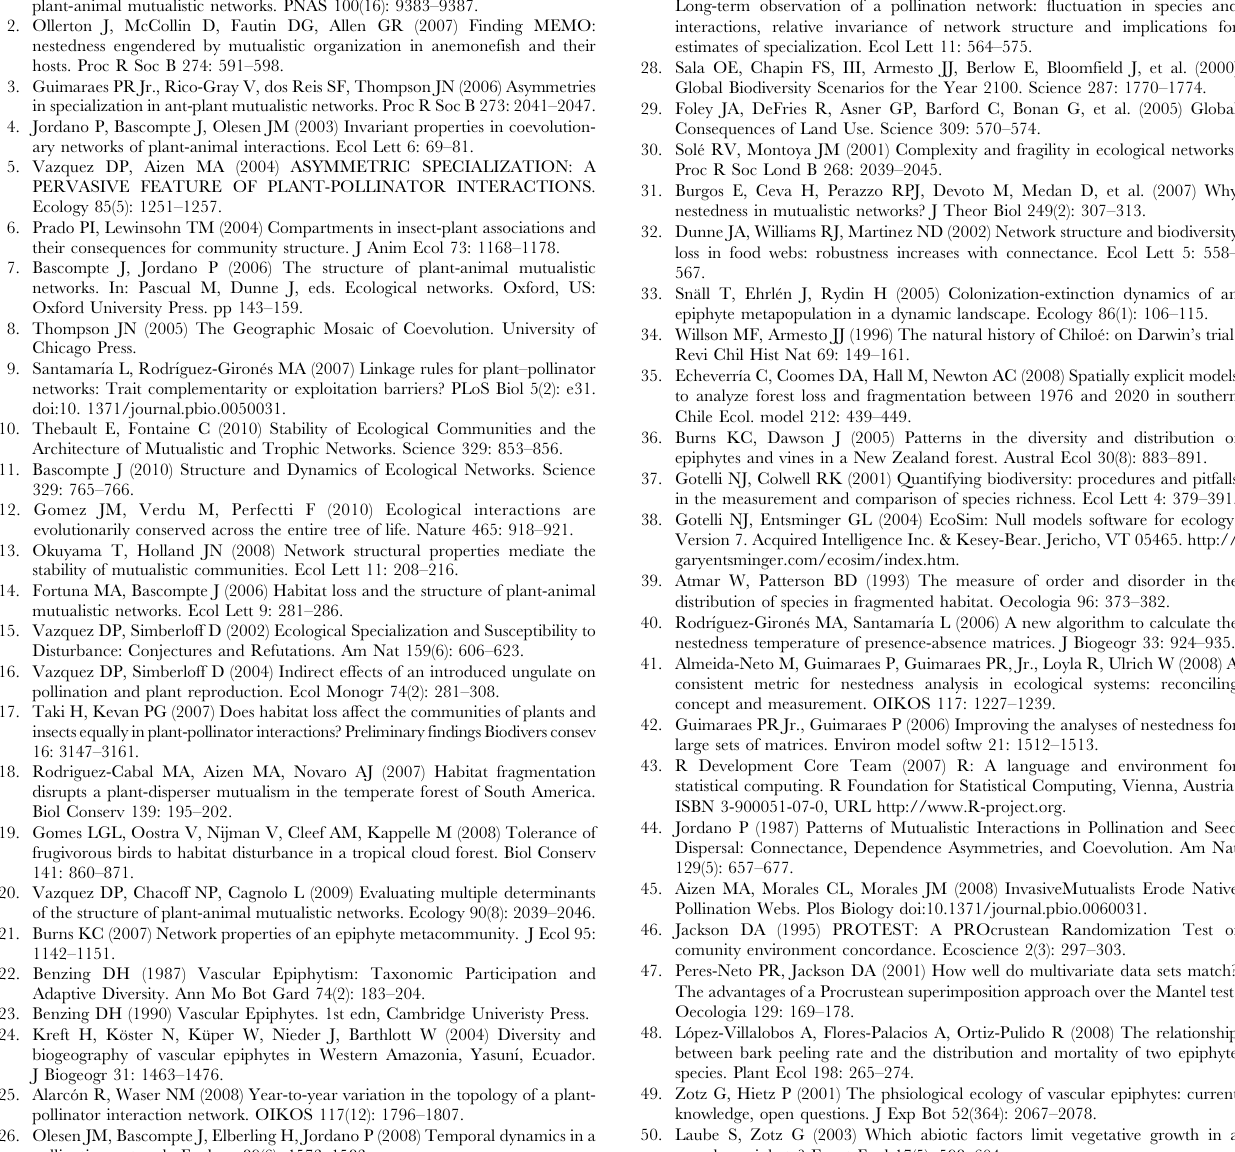
Table S3 Epiphyte-host tree quantitative networks sampled during the field survey . a) and b) are old-growth forests, while c) and d) are disturbed